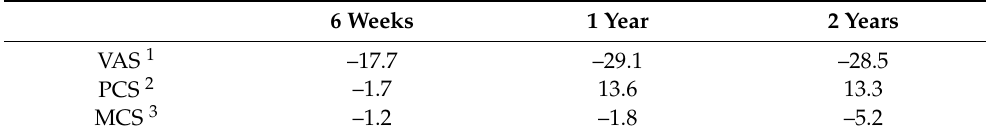
Table 3. Mean absolute changes of pain intensity and health-related quality of life outcomes of the patients ( n = 25) according to baseline measurements.